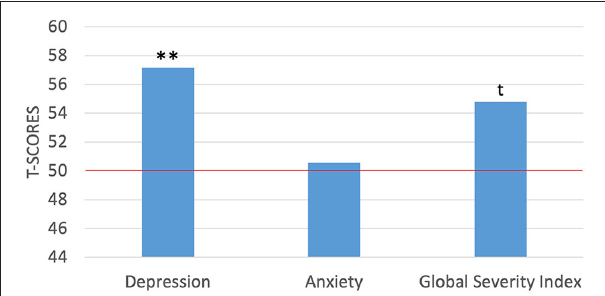
FIGURE 1 | One-sample t -tests between maternal self-report of mental health symptoms against the normed sample of the SCL-90-R. ** p < 0.01 ; t p = marginally significant. Red horizontal line indicates the normed sample mean of